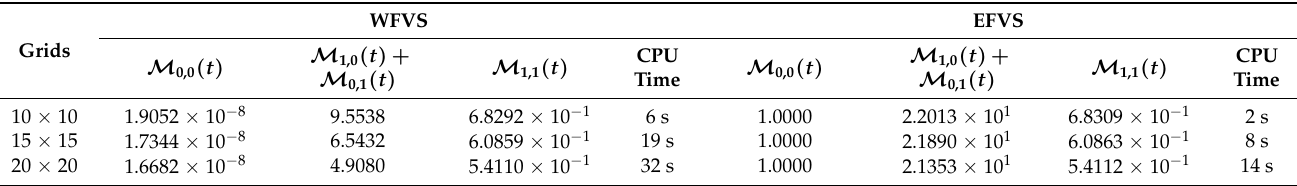
Table 7. Relative error for the weighted moments at different grid points for the test case with S = 1 and breakage functions b 3 at t = 10.